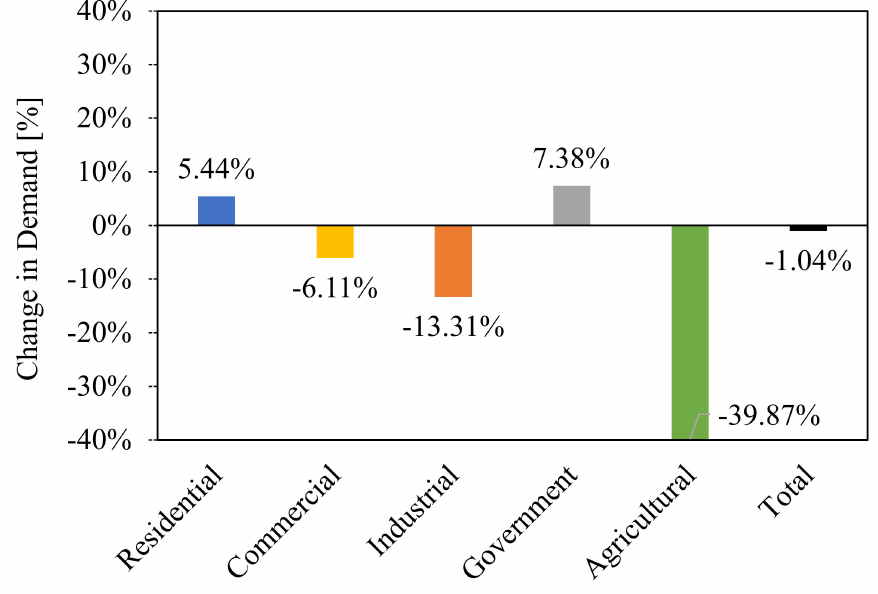
Figure 11. The change in electric power demand per sector in 2020 in comparison to the average of previously reported